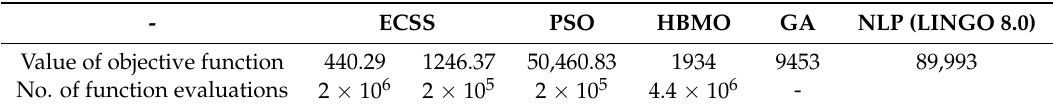
Figure 3. Surface of the 2-variable Fletcher–Powell function. Table 4. Results of the ECSS algorithm in comparison with the other rival metaheuristics algorithms for 30-variable Fletcher–Powell function.